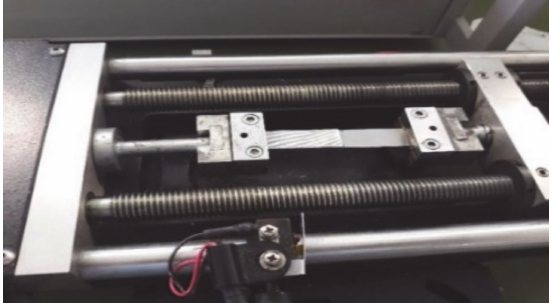
Figure 3. Setup of MiniMat 2000 Machine for the tensile testing of titanium-PLA